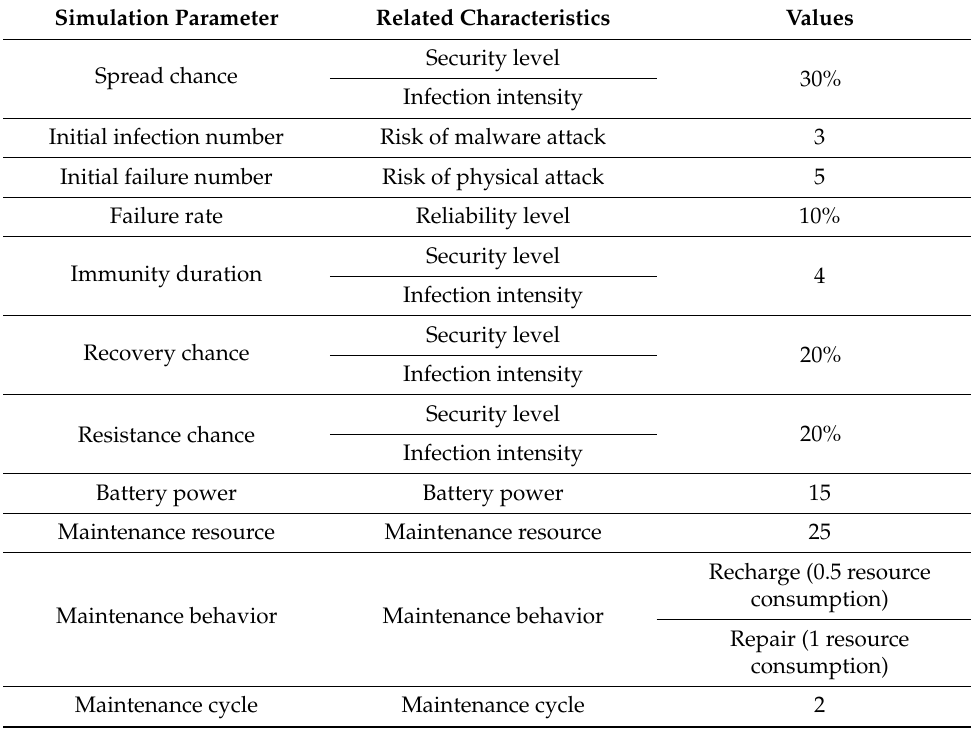
Table A5. Scenario 2 with simulation parameters and